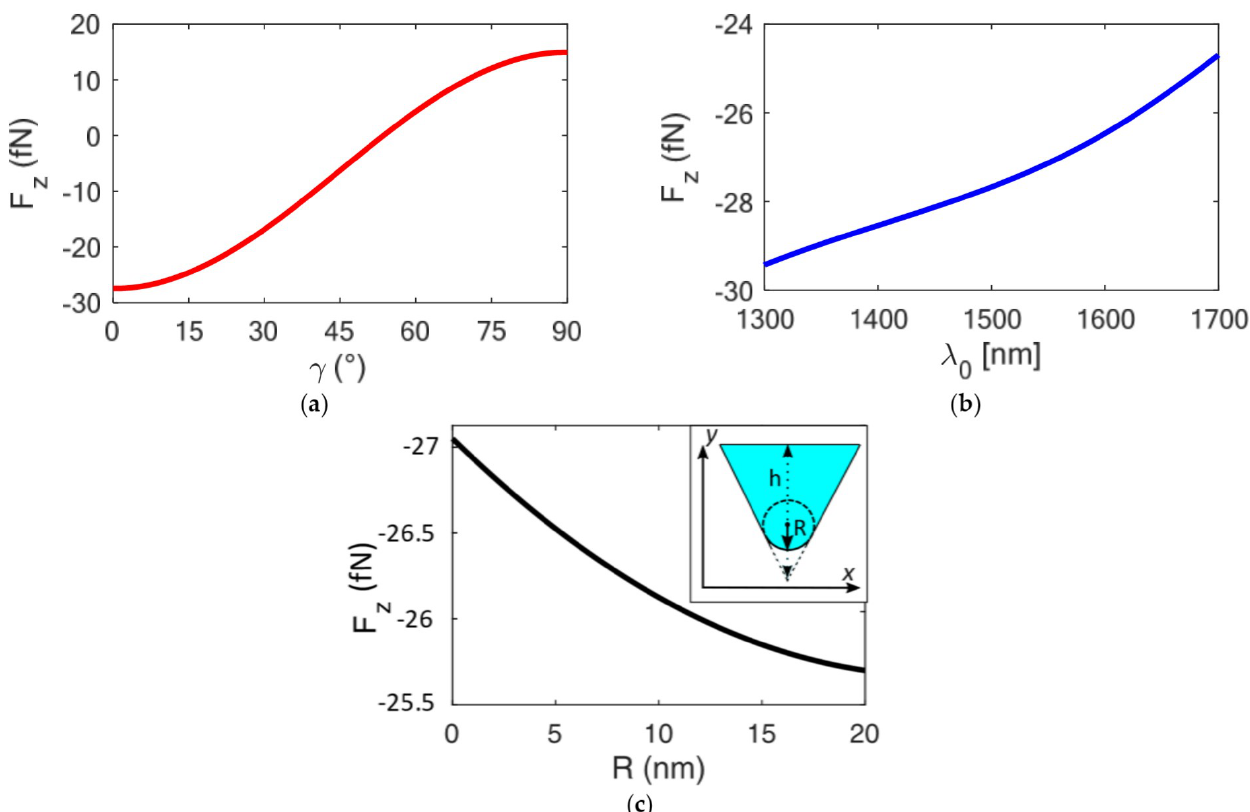
Figure 8. Optical force F z behavior at the equilibrium point, varying the polarization direction γ ( a ), operating wavelength λ 0 ( b ), and the radius R of the wedge fillet shape ( c ) with P norm = 6 mW/ µ m 2